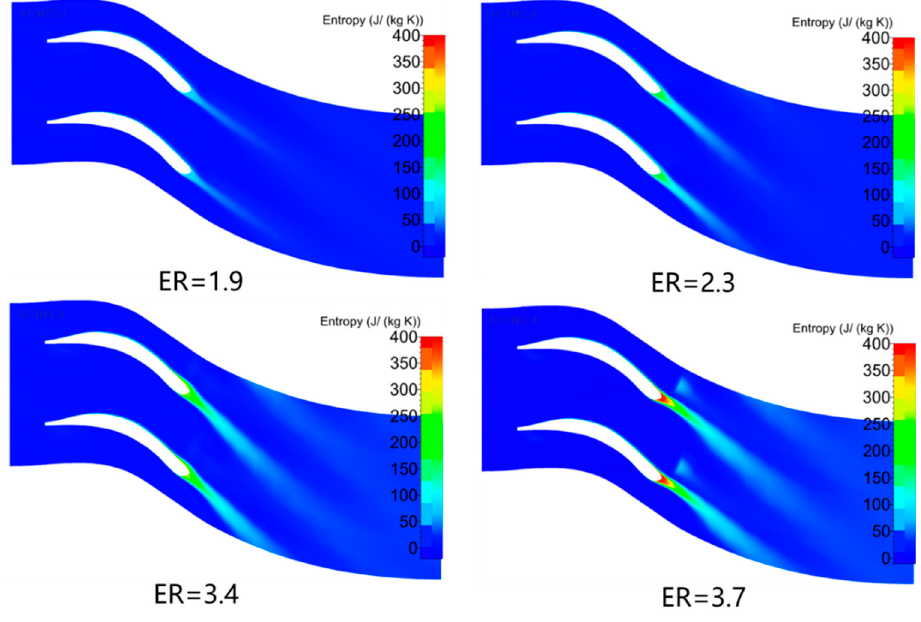
Figure 8. The distribution of entropy at different expansion ratios.